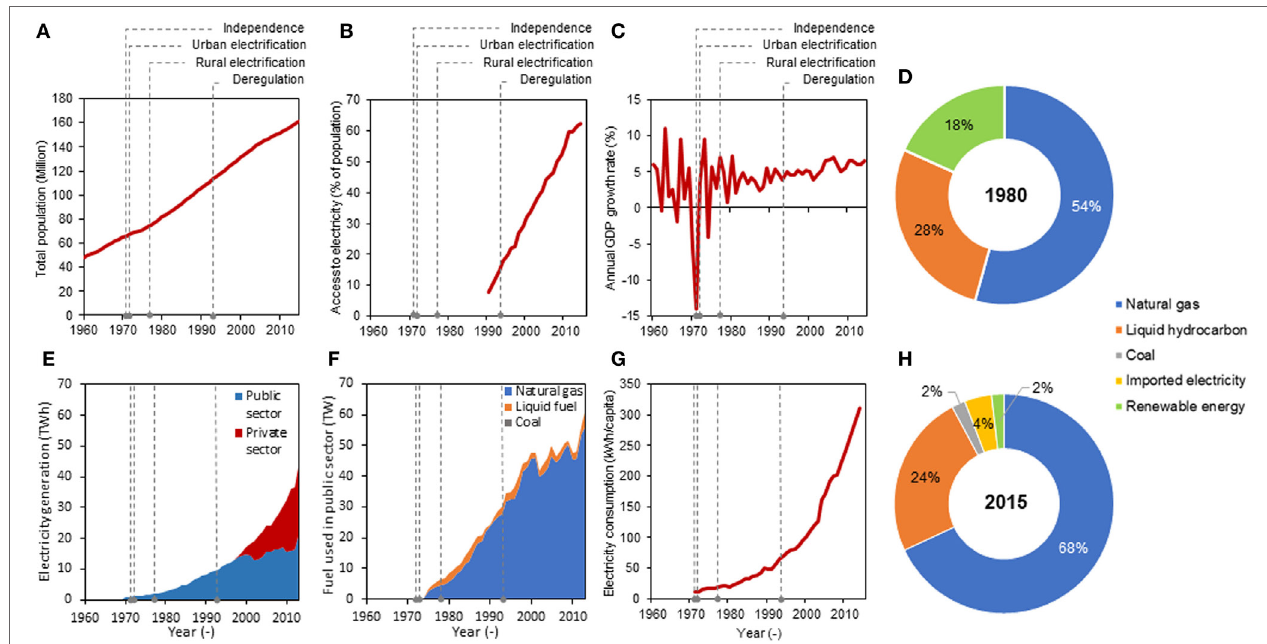
FigUre 1 | (a) Population of Bangladesh (1960–2015); (B) access to electricity (1970–2015); (C) annual GDP growth (1960–2015); (d,H) fuel types for electricity generation in 1980 and 2015. The total installed capacity was 438 and 12,504.37 MW, respectively, in 1980 and 2015 (28.5 times increase in 35 years); (e) electricity generation in Bangladesh (1970–2013); (F) fuel use for electricity generation (1970–2013); (g) electricity consumption per capita (1971–2014). The dotted lines in the figures illustrate the key historical events, which influenced the electricity sector of